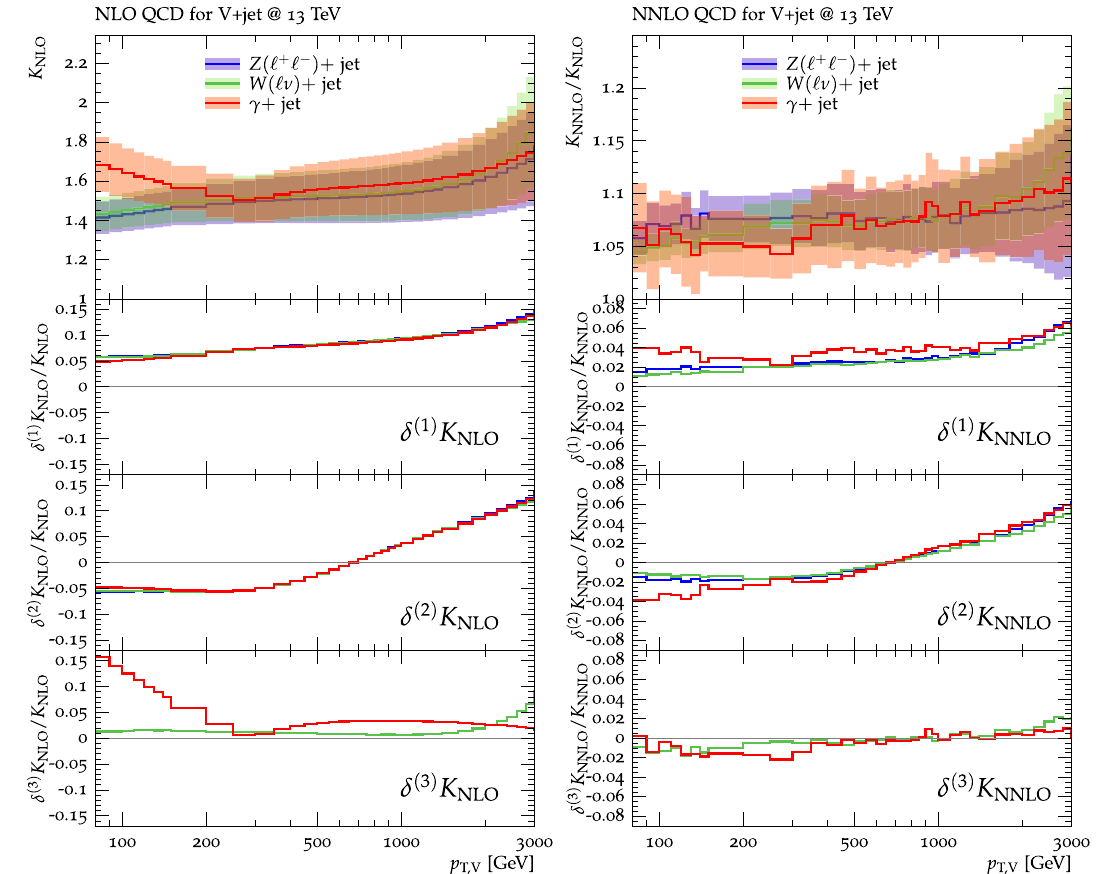
Fig. 7 QCD K -factors at NLO (with respect to LO) on the left and at NNLO (with respect to NLO) on the right for the various pp → V + jet processes at 13TeV. The bands in the upper frame correspond to scale variations, i.e. δ ( 1 ) K NLO and δ ( 1 ) K NNLO . The lower frames show the